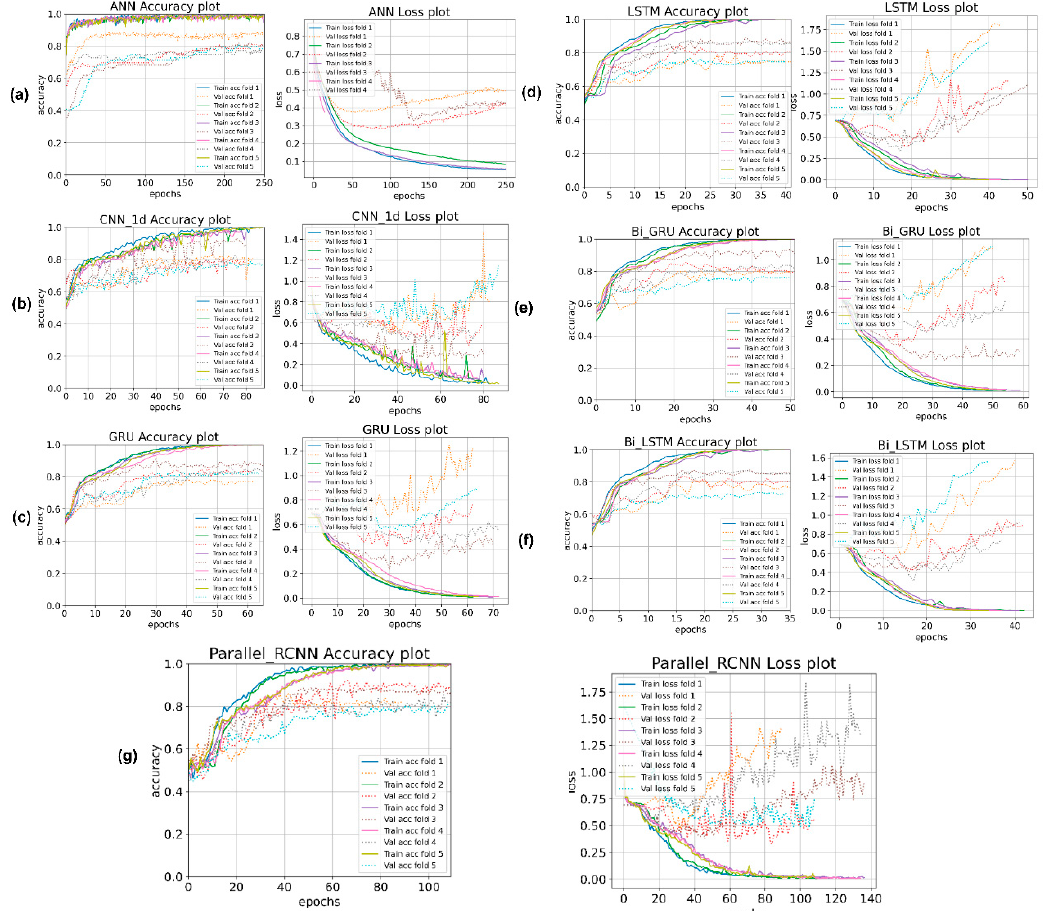
Figure 5. The accuracy and loss curves for the five-fold in ( a ) ANN, ( b ) CNN, ( c ) GRU, ( d ) LSTM, ( e ) Bi-GRU, ( f ) Bi-LSTM and ( g ) Parallel RCNN.